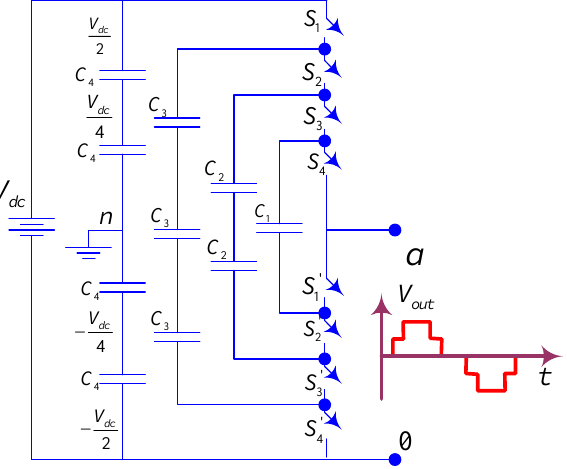
Figure 6. Five-level FC-MLI.